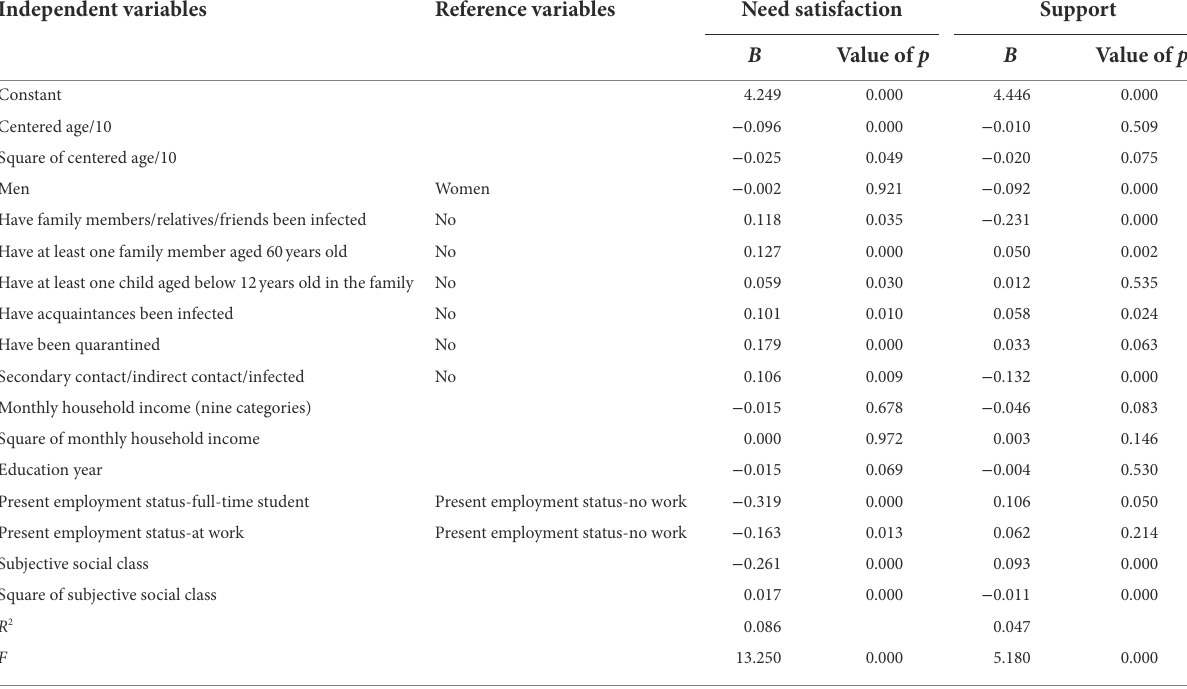
TABLE 4 Linear regression results on need dissatisfaction and support for anti-pandemic behaviors ( N = 6,022). Independent